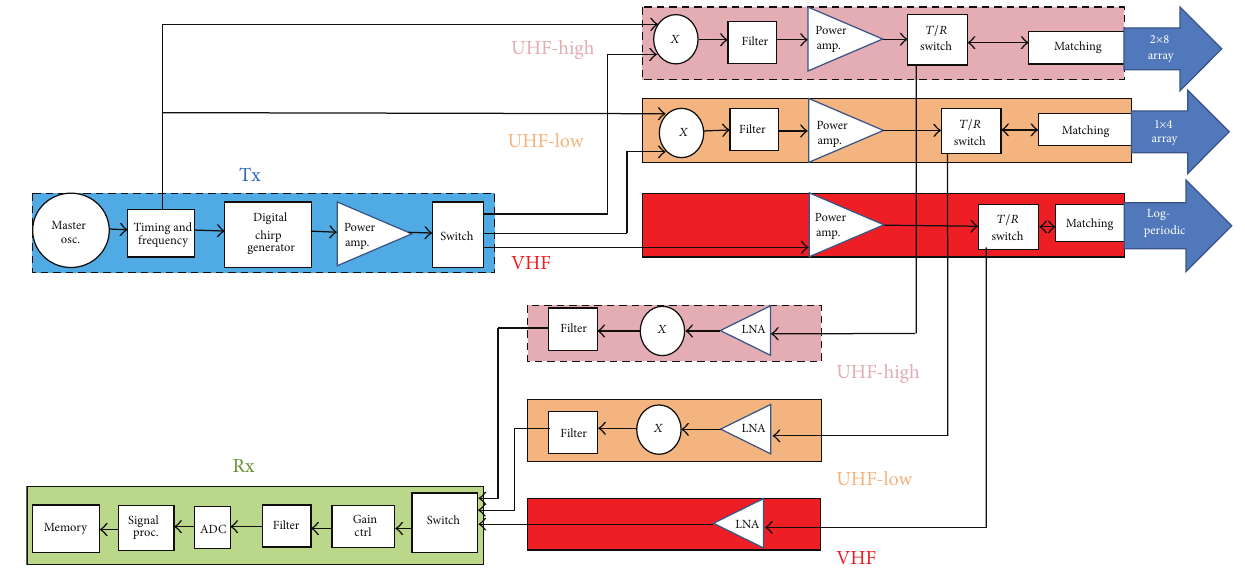
Figure 2: General system